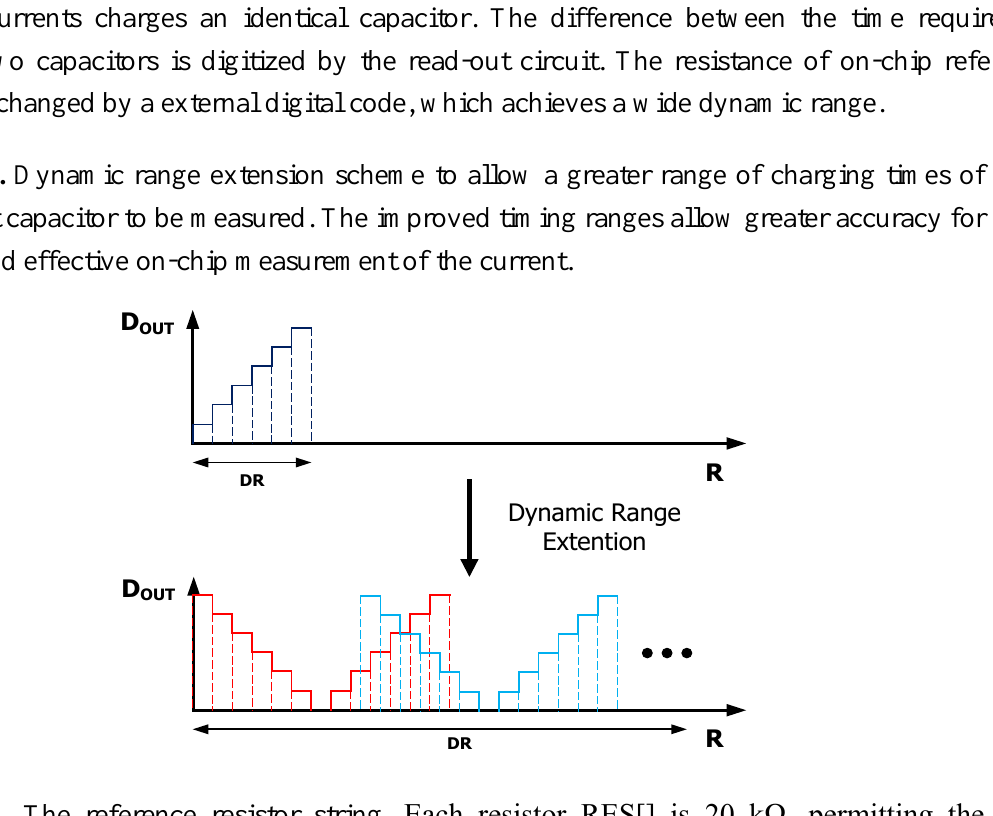
Figure 7. The reference resistor string. Each resistor RES[] is 20 kΩ, permitting the resistance to be dynamically varied from 20 kΩ to 320 kΩ in 20 kΩ